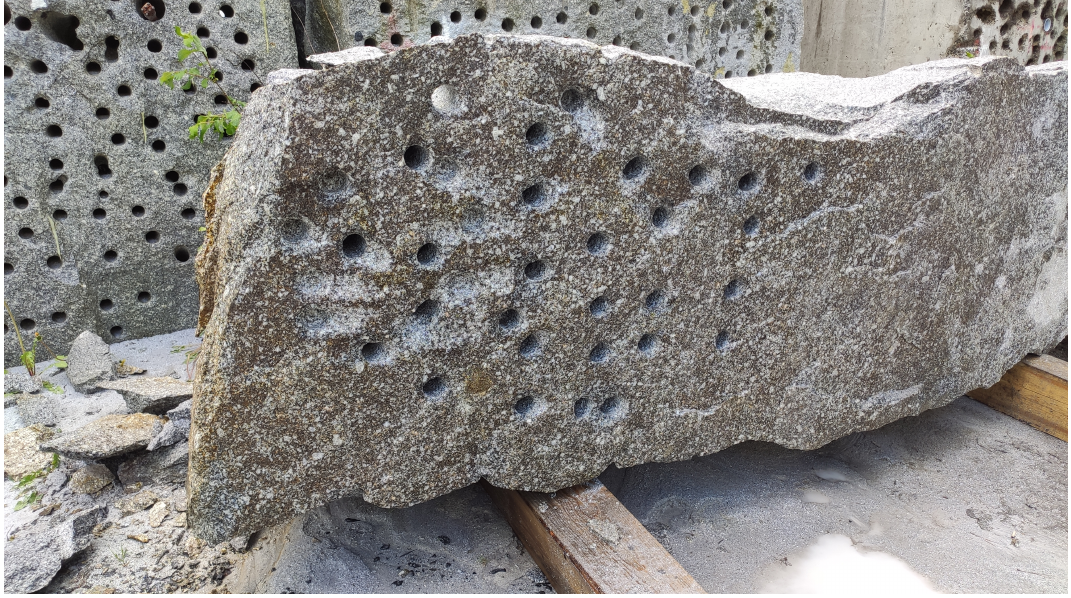
Figure 3. Granitoid block used in the